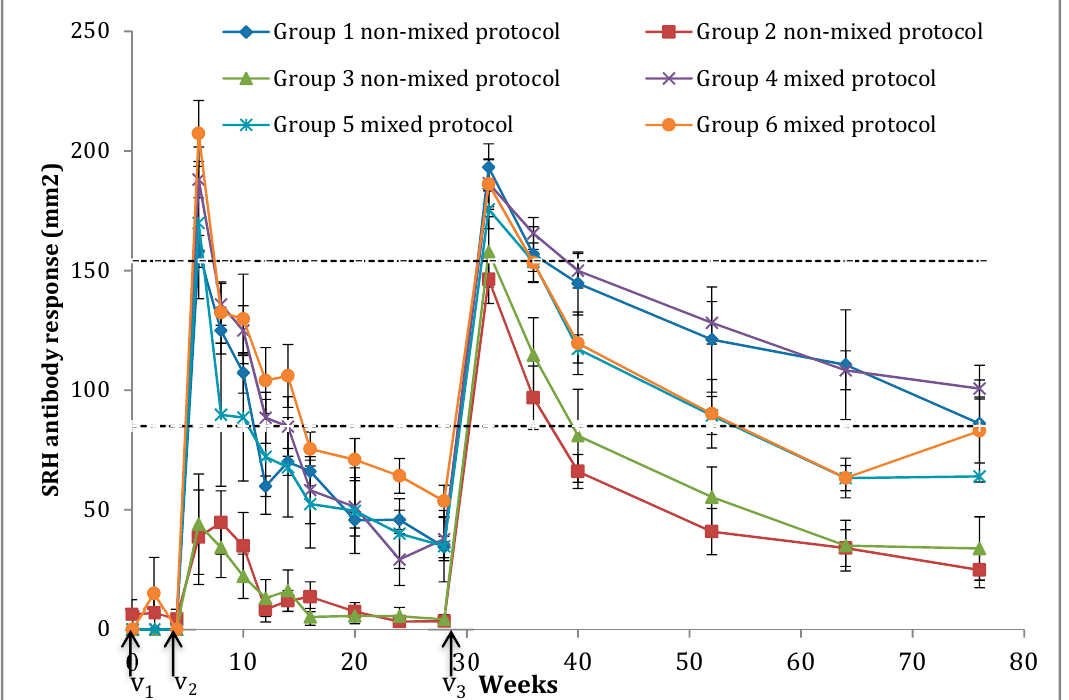
Figure 1. Mean SRH antibody in vaccinated weanlings measured against A/equine/Richmond/1/07. Broken lines represent SRH antibody level 85 mm 2 and 154 mm 2 correlating with clinical and